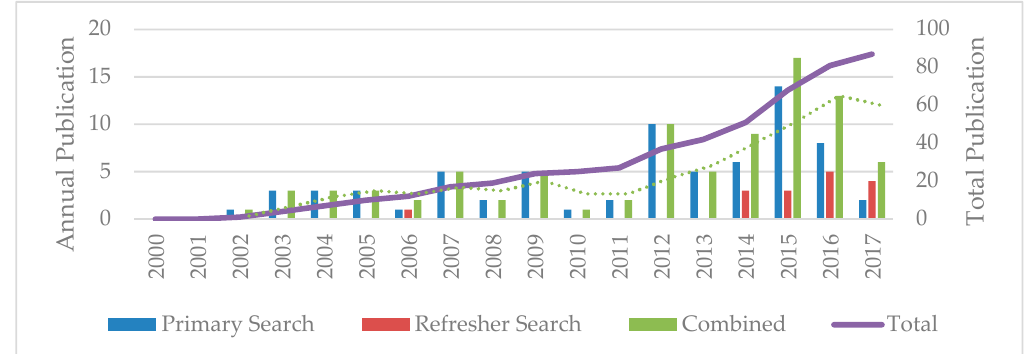
Figure 2. Rate of publication suggests an increase in the research effort being directed towards understanding the links between public green infrastructure (PGI) and urban livability since the year 2000 (n = 71). Green dotted line is the 3-year rolling average for annual publication rate.